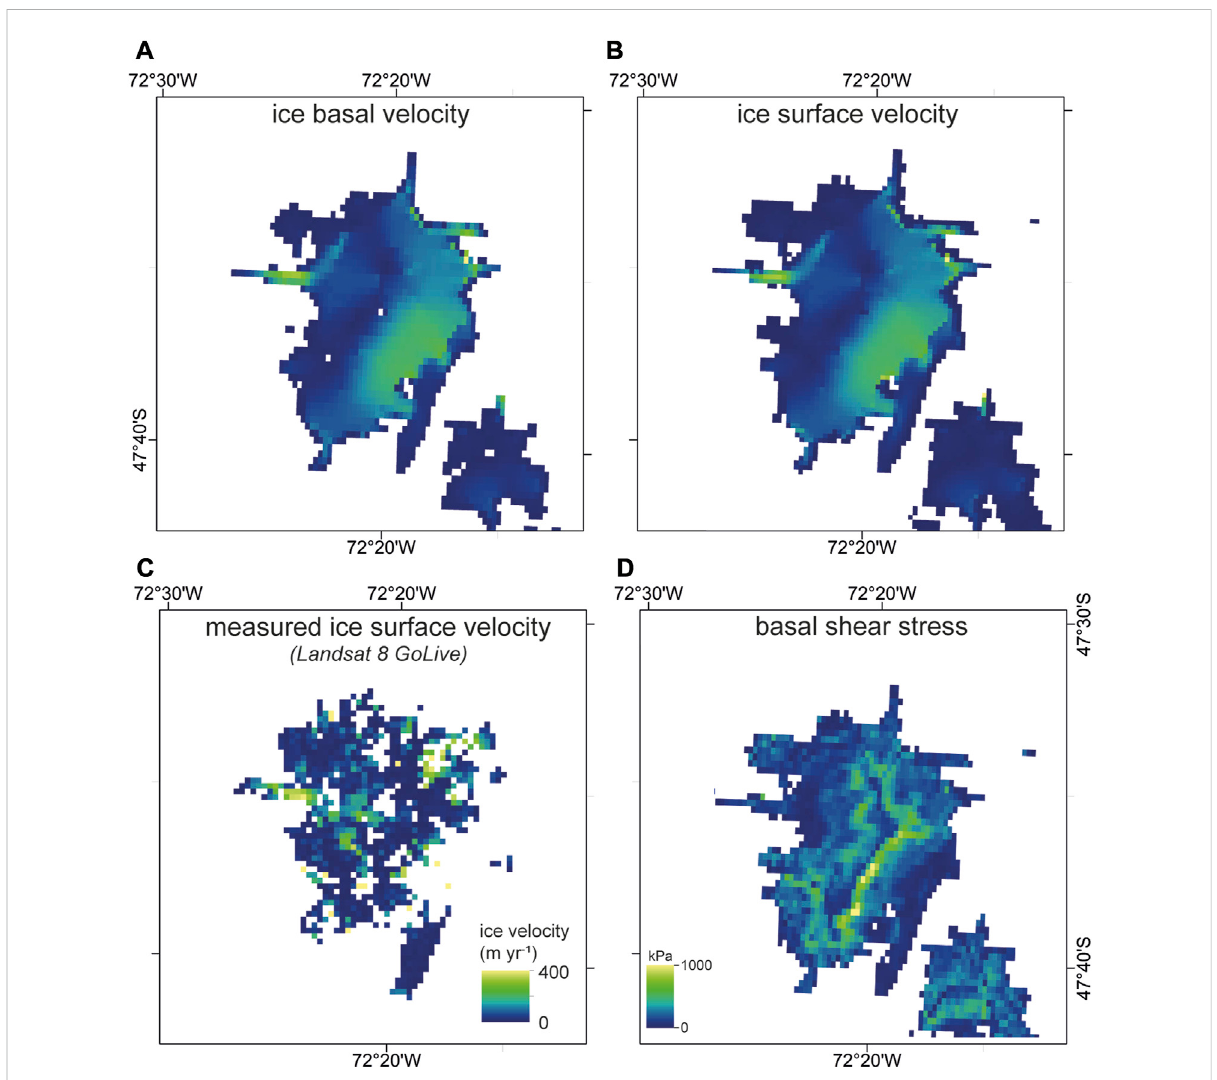
FIGURE 8 Basal ice (A) and surface ice (B) velocity of the modelled MSL ice cap. (C) Ice surface velocity of the MSL ice cap taken from the Global Land Ice Velocity Extraction from Landsat 8 (GoLIVE), Version 1 (image L8_231_093_032_2017_307_2017_339_RTT1, 3/11/2017 to 5/12/2017) (Fahnestock et al., 2016; Scambos et al., 2016). (D) Modelled basal shear stress opposing the driving stress resulting from